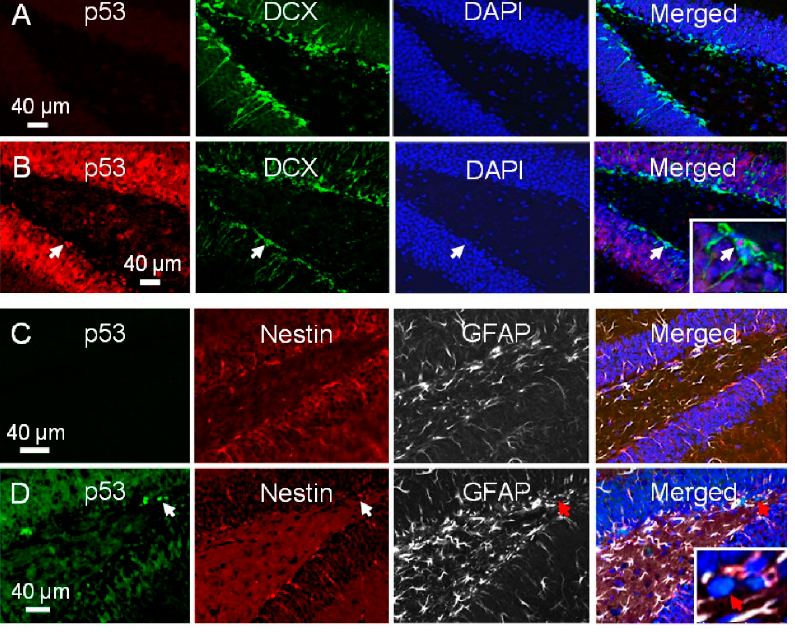
Figure 7. Cont. Figure 7.